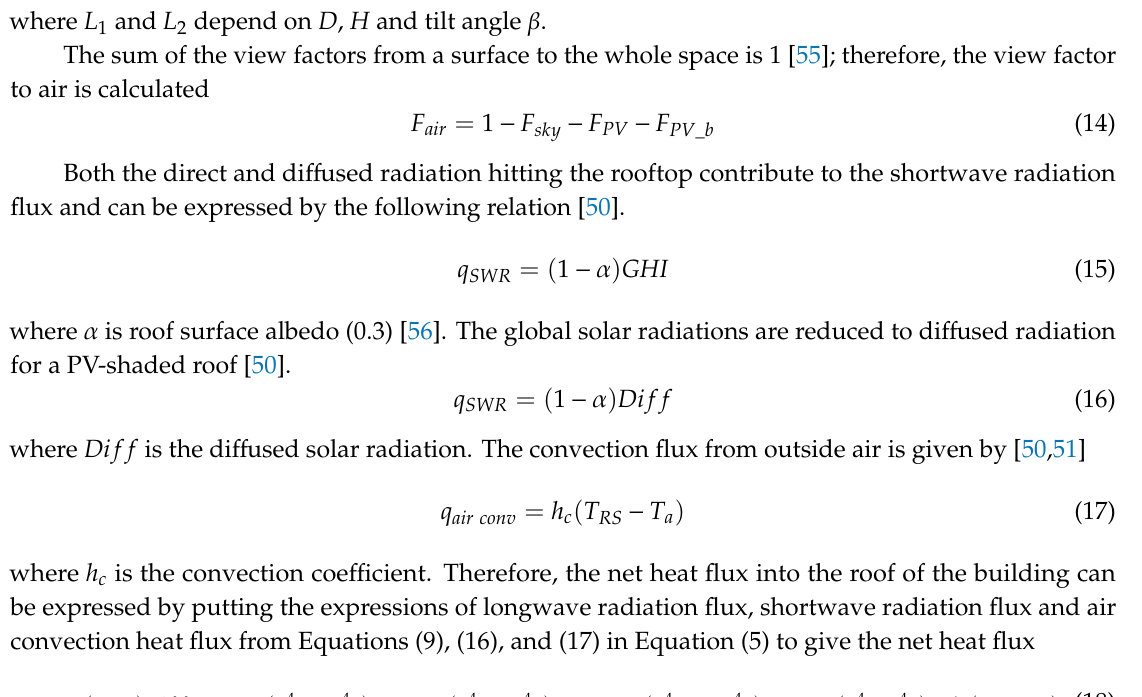
Table 4. Parameters of building.